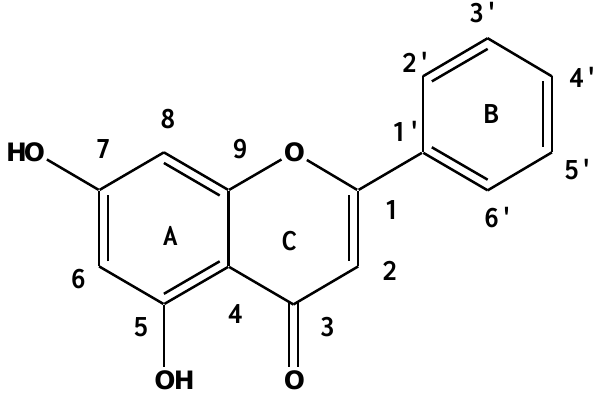
Figure 1. Chemical structure of genistein.